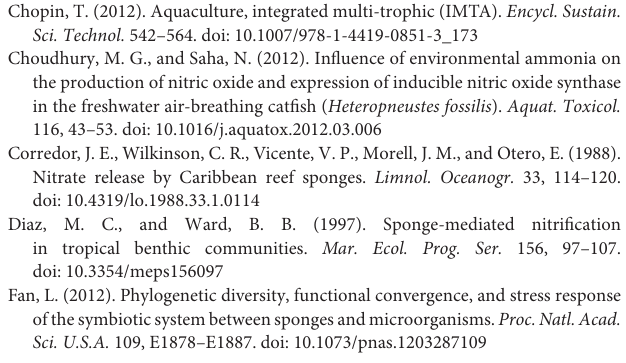
Supplementary Figure 1 | Schematic sketch and photographs of the system used for water sampling and for measuring the concentration of dissolved oxygen. (A) Schematic sketch of the system, not to scale. 1 – Oxygen module with a PC (2) showing (3) the in situ oxygen readings by IN (green) and EX (red) optodes; 4 – temperature sensor; 5, 6 – water sampling sets and optodes; 7 – sponge explant attached to the substrate; 8 – tubes for collection of water samples; 9 – sub-samples for subsequent analyses. (B) Photograph of the sponge in aquarium with the sampling sets held by the GorillaPod manipulator, and the temperature sensor attached to the aquarium wall on the right; (C) close-up photograph of the sampling set, with an additional close-up (D) showing the tip of the oxygen sensor (top) and the tip of the water sampling capillary (bottom). Supplementary Figure 2 | Photographs of the sponge Chondrosia reniformis during and after the experiment. (A) a sponge at the beginning of the experiment (July 2014), the arrow points to attachment of the sponge to a porcelain tile. (B) The same sponge after 4 months of handling in aquarium (October 2014), arrows point to the open osculae. (C) The same sponge after the experiment (May 2015). The scale bar under the sponge number is